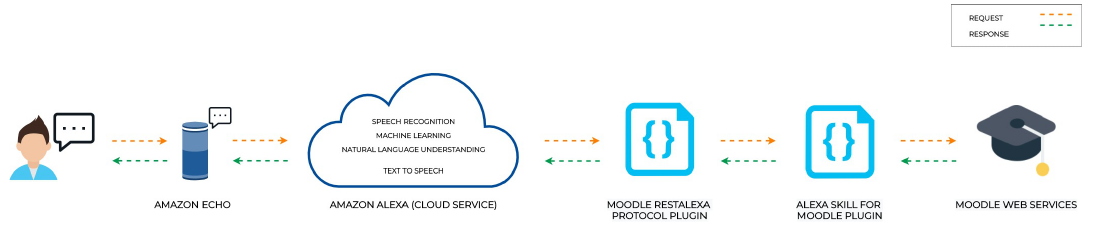
Figure 2. Graphical representation of Melton [35] prototype architecture (Source: own authors’